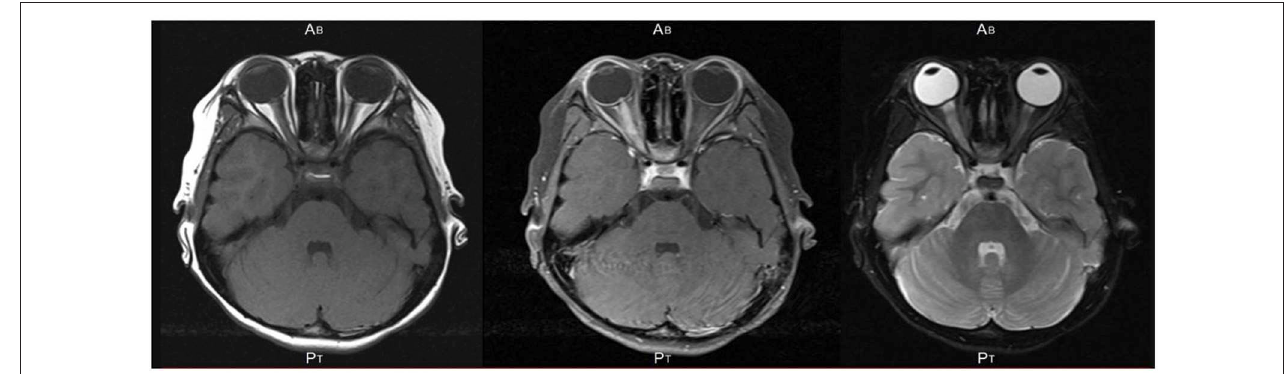
FIGURE 2 | An axial section of magnetic resonance images of the brain and orbits in the patient showing hyperintensity of the right optic nerve on short TI inversion recovery (STIR) sequence (Left) , T1-weighted image with gadolinium enhancement (Middle) , and T2-weighted image (Right) . No cerebral lesion was detected. An axial section of MRI of the brain and orbits in the patient showing hyperintensity of the right optic nerve on short TI inversion recovery (STIR) sequence and no cerebral lesion.